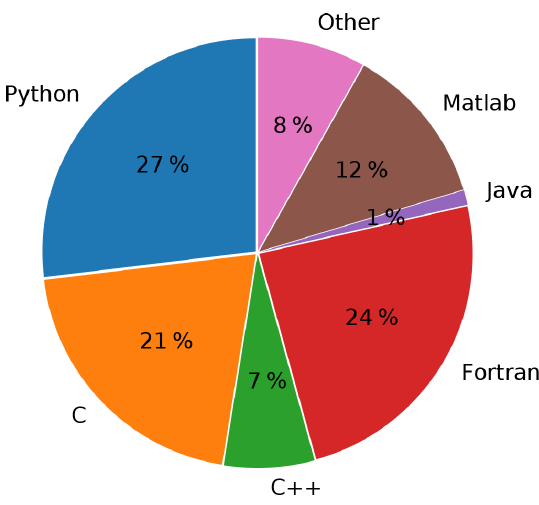
Figure 4. Distribution of different languages used by models and tools in the CSDMS model repository (percentages out of 453 total programs; not weighted by program